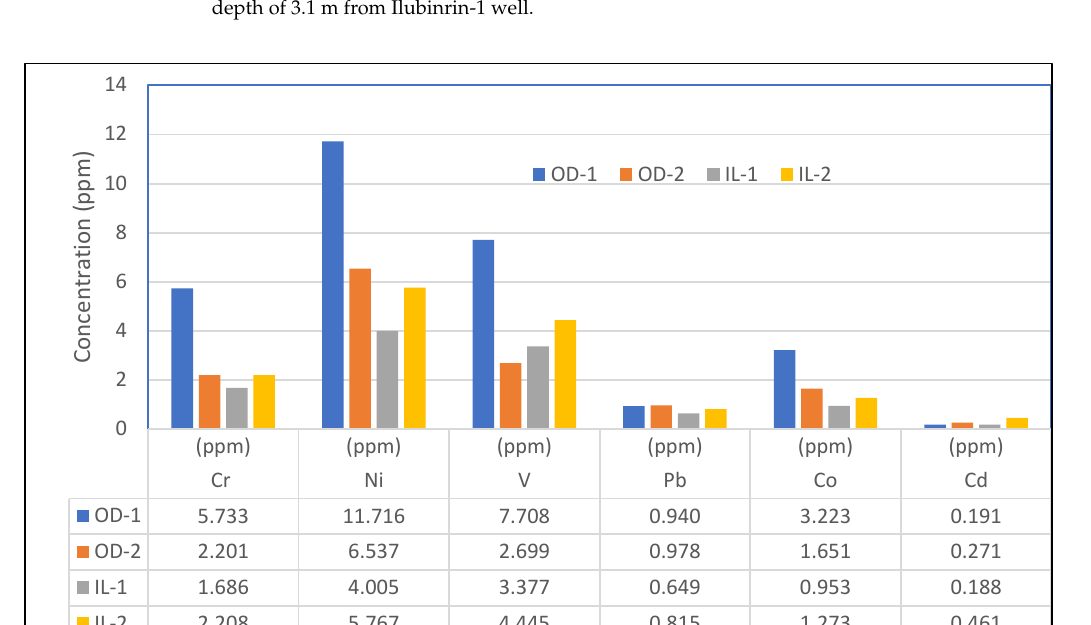
Note: SD = Standard deviation. OD-1= oil sand at a depth of 2.5 m from Ode-Aye-1 well. OD-2= oil sand at a depth of 4.1 m from Ode-Aye-1 well. IL-1 = oil sand at a depth of 2.0 m from Ilubinrin-1